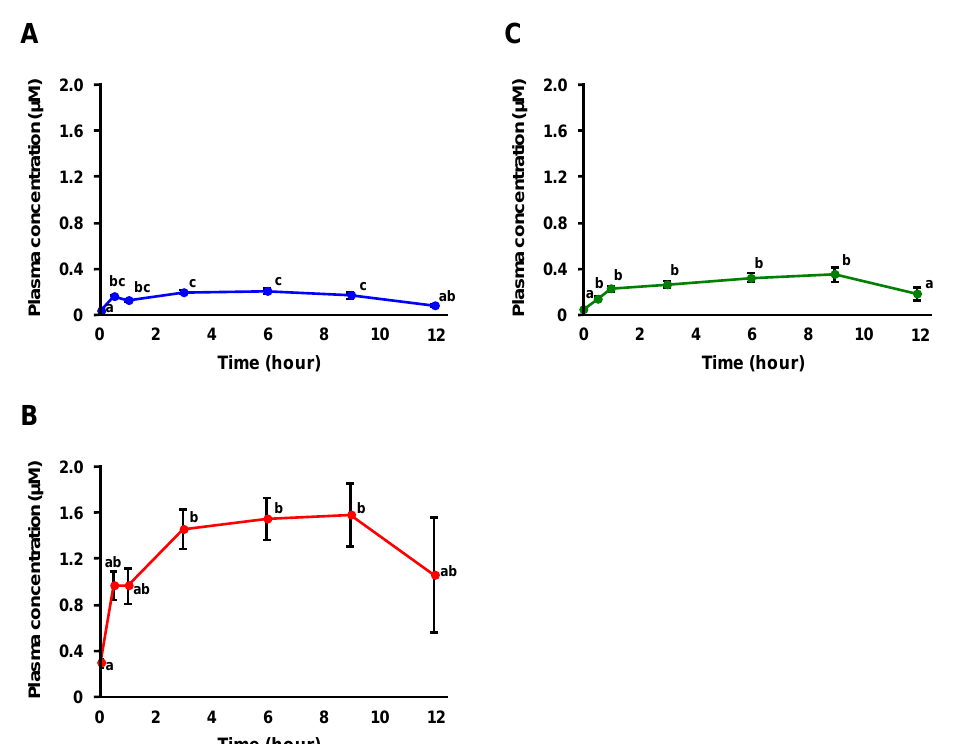
Figure 4. Typical MRM chromatograms of FA and FA conjugates in plasma before ( A ) and 6 h after RBOZ administration ( B ). Each MRM pair represents analysis of the following FA and FA conjugates: m / z 192.9 > 133.8, ferulic acid; m / z 272.9 > 192.8, ferulic acid 4- O -sulfate; m / z 369.0 > 112.8, ferulic acid 4- O -β- D -glucuronide.